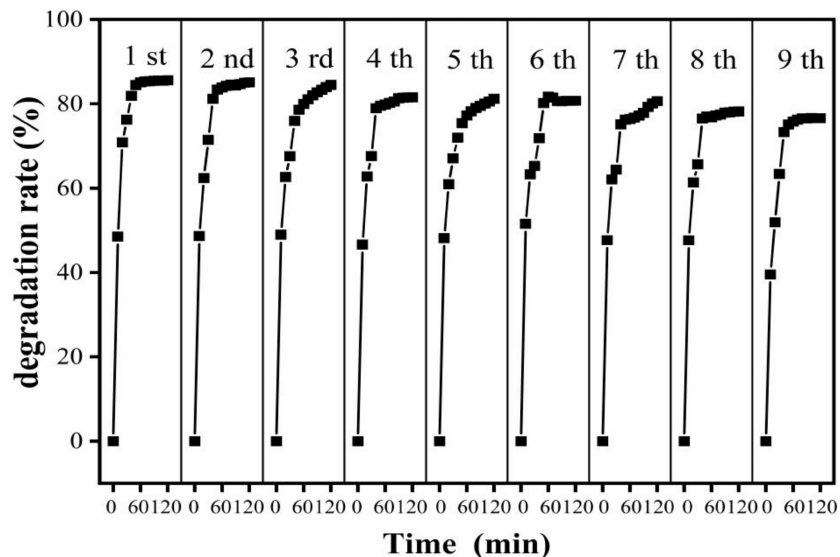
Figure 6. Nine cycles of the photocatalytic behaviors of TWCu7 for formaldehyde under UV-Vis light for 2